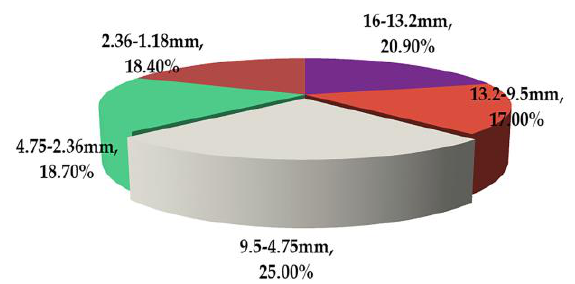
Figure 18. Contribution rate of coarse aggregates with different sizes for y-axis rutting deformation.